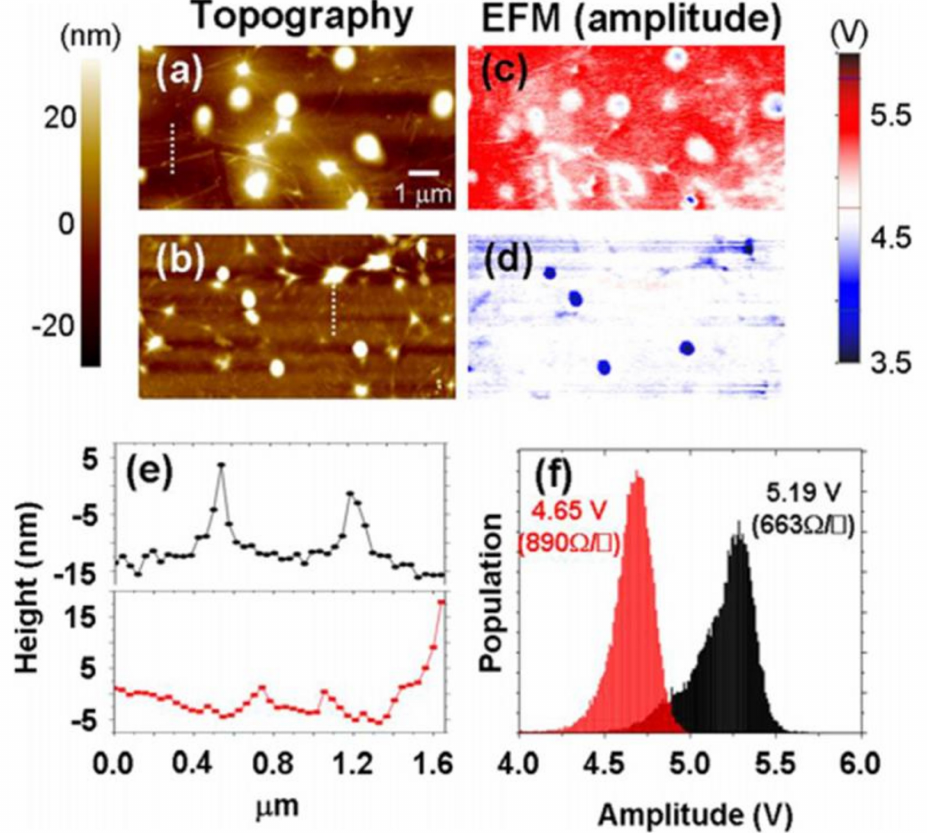
Figure 11. ( a , b ) showed the contour of the transferred CVD-MG on PET substrate. The CVD-MG boundaries in ( a ) were evidently noticed, while those in ( b ) were hardly seen due to stretched formation of CVD-MG boundaries toward the PET surface. ( c , d ) were the corresponding EFM amplitude images of ( a , b ), respectively. ( e ) Dotted line profiles of each topography were utilized to clearly identify the boundary shape of the transferred CVD-MG films. The upper line profile showed the case of ( a ) and the bottom profile indicated ( b ) case. ( f ) Statistical distribution of electrostatic amplitude of each case. Red and black histogram indicating the ( c , d ) cases, respectively. The red histogram shows the strong electrostatic attractive force with PET surface and the correlating higher sheet resistance value, whereas the weak electrostatic attractive force with PET surface and correlating lower sheet resistance value are presented in the black histogram. Reprinted with permission from ref.